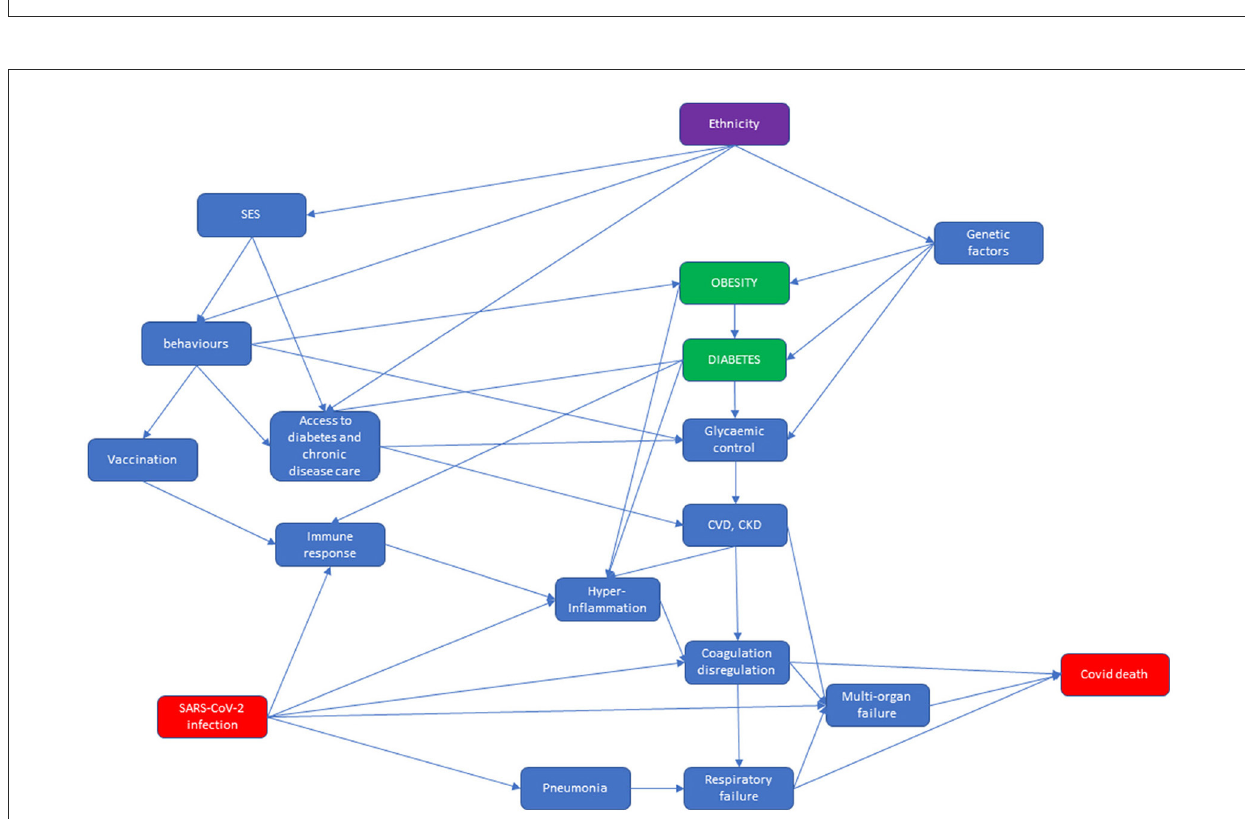
FIGURE2 COVID-19 vaccination coverage for HDC and HMPC populations for the adult population residing in Reggio Emilia, as of August 10, 2021.